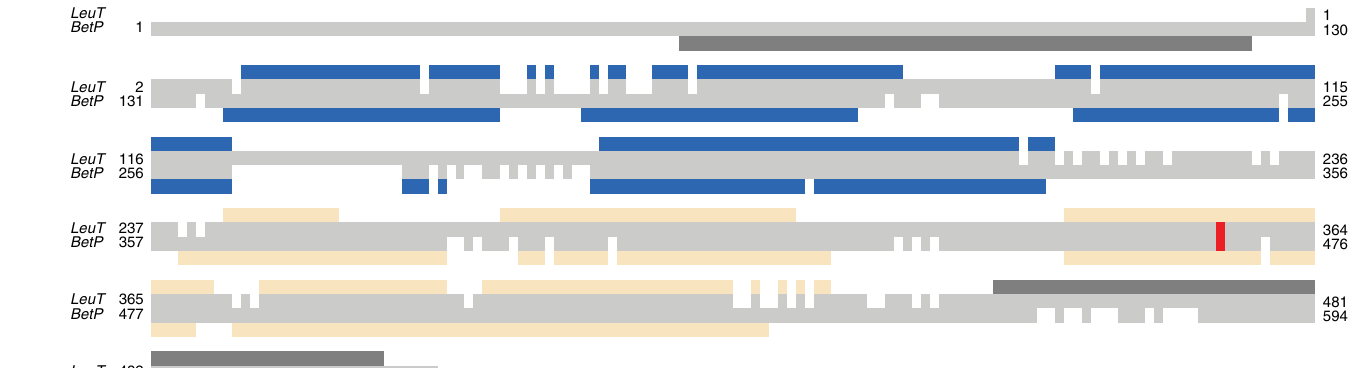
Fig 3. Pairwise sequence alignments of the membrane proteins BetP and LeuT can be corrected using anchors. Alignments were obtained either with a standard protocol (A) or with a single anchor imposed ( red ) restraining one column in either the first (B) or eighth (C) transmembrane segments of the core LeuT fold. Boxes above and below the respective sequences indicate the location of the transmembrane segments of the two proteins and highlight the related elements in the first ( blue ) and second ( wheat ) repeats. Transmembrane segments that are peripheral to the core fold are colored dark gray. See Fig 1 for more information.